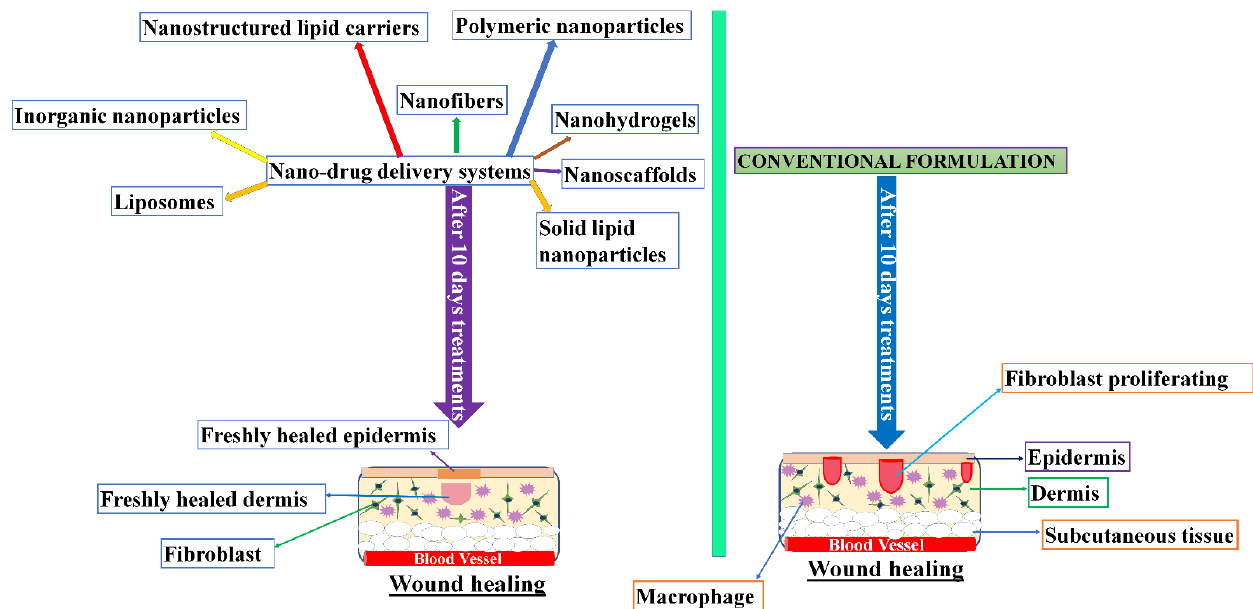
Figure 2. A comparison of nano-drug delivery systems involved in the skin regeneration and wound treatment with conventional drug delivery systems.